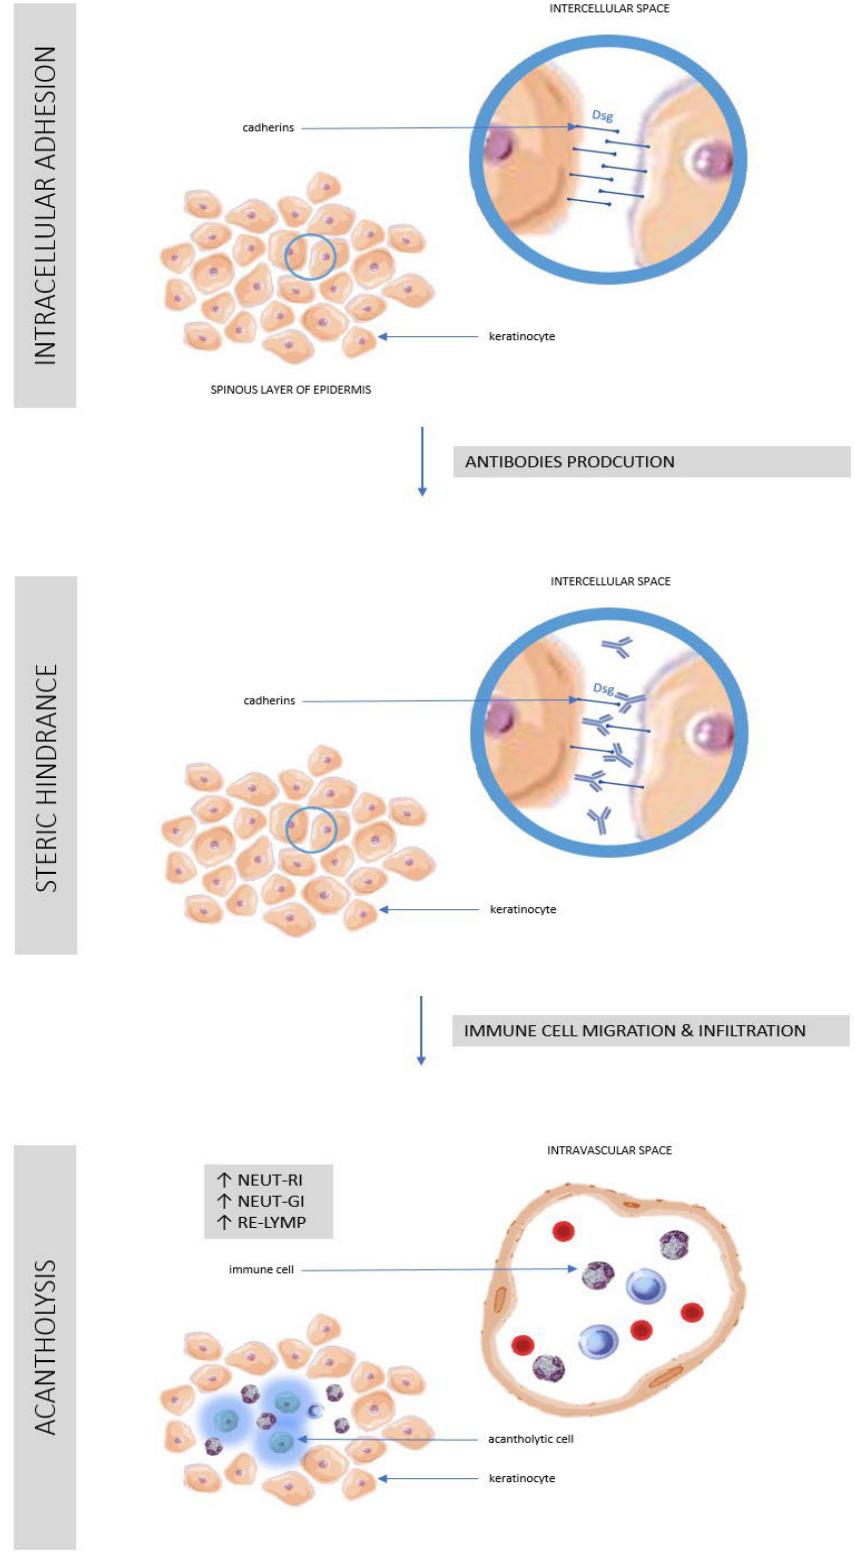
Figure 3. Pathophysiology of pemphigus and the role of immune cells in the development of lesions. See references in main text. (AS-LYMP–Antibody-Secreting Reactive Lymphocytes, NEUT- GI–Neutrophil Granularity Intensity, NEUT-RI–Neutrophil Reactive Intensity, RE-LYMP–Reactive